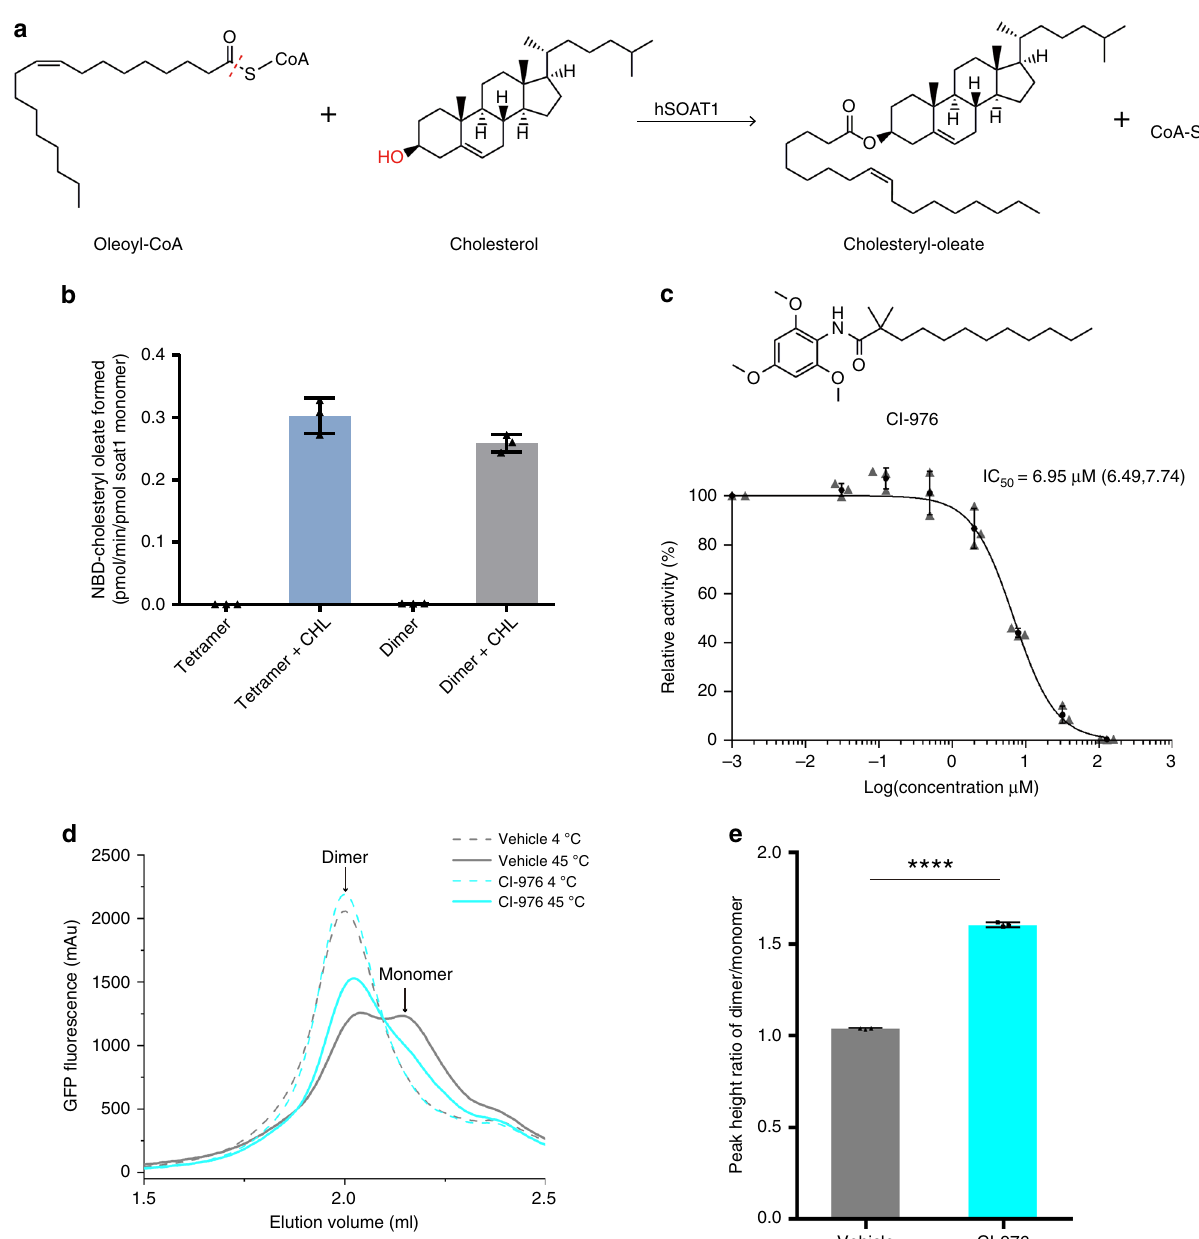
Fig. 1 The enzymatic reaction catalyzed by hSOAT1. a Chemical structures of the substrates and products of hSOAT1 enzyme are shown. The red dashed line indicates the bond that is broken during acyl-transfer reaction. The hydroxyl group that accepts acyl group is highlighted in red. b The activation effect of cholesterol (CHL) on the esteri fi cation reaction of NBD-cholesterol catalyzed by hSOAT1 tetramer and dimer (Data are shown as means ± standard deviations, n = 3 biologically independent samples). c Chemical structure of CI-976 and dose-dependent inhibition curve of hSOAT1 tetramer by CI-976 (The fi rst data point is an arti fi cial point. Data are shown as means ± standard deviations, n = 3 biologically independent samples, and numbers in parentheses are the range for IC50 obtained from curve fi tting). d Representative fl uorescence-detection size-exclusion chromatography (FSEC) traces of N terminal GFP-tagged SOAT1 dimer at 4 °C (dashed lines) or 45 °C (solid lines) in the presence of 100 µ M CI-976 (cyan) or DMSO alone (vehicle, gray). The elution positions of SOAT1 dimer and putative monomer are labeled by arrows. e The peak height ratio of the dimer/monomer in the presence of DMSO alone (vehicle, gray) or 100 µ M CI-976 (cyan) (Data are shown as means± standard deviations, n = 3 biologically independent samples, **** p < 0.0001; two-tailed paired t -tests). Source data are provided as a Source Data fi